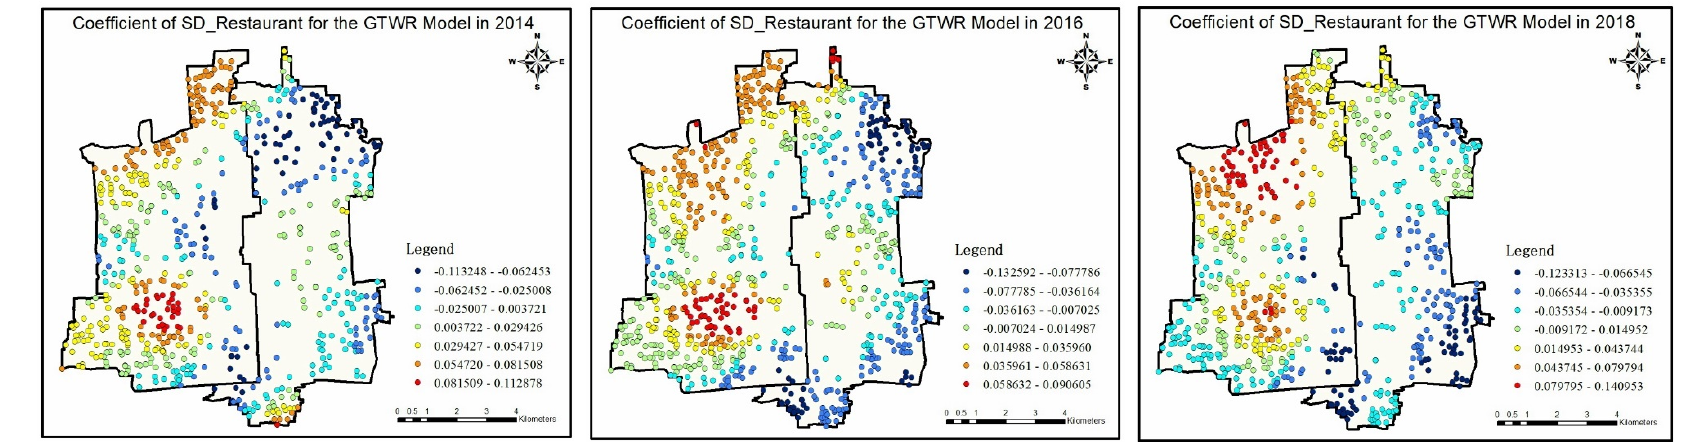
Figure 9. Coefficient of SD_Restaurant for the GTWR model in 2014, 2016, and 2018.